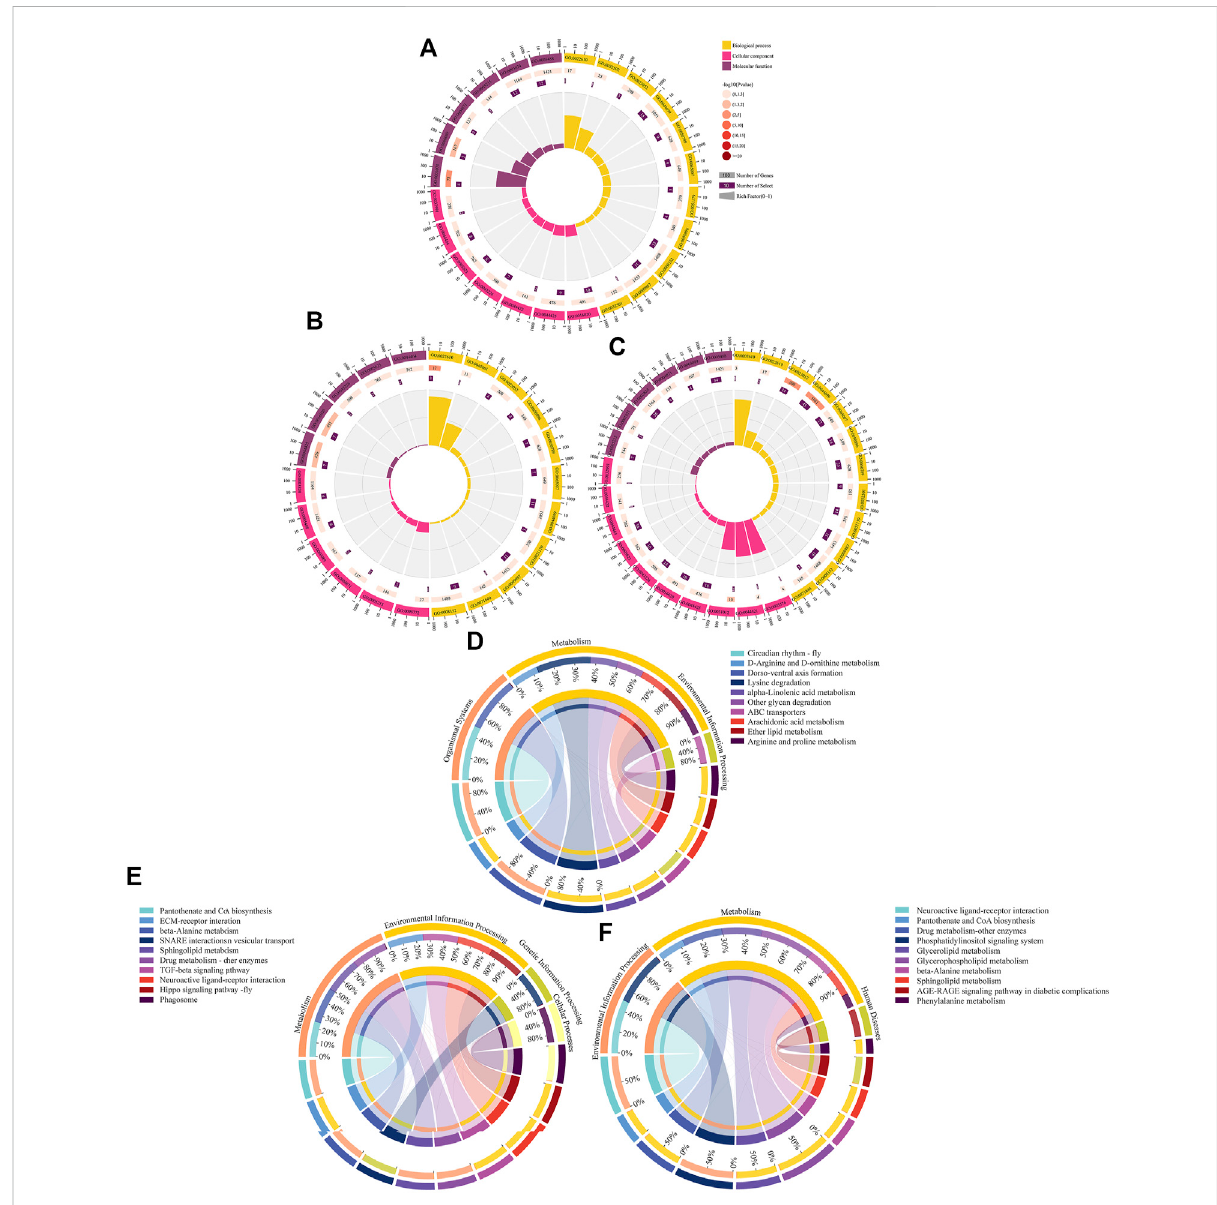
GO terms and KEGG pathways enriched by target DEmRNAs within ceRNA networks in three comparison groups. (A – C) Loop graphs of enriched GO terms by targets in AmCK1 vs. AmT1, AmCK2 vs. AmT2, and AmCK3 vs. AmT3 comparison groups. (D – F) Chord graphs of enriched KEGG pathways by targets in AmCK1 vs. AmT1, AmCK2 vs. AmT2, and AmCK3 vs. AmT3 comparison